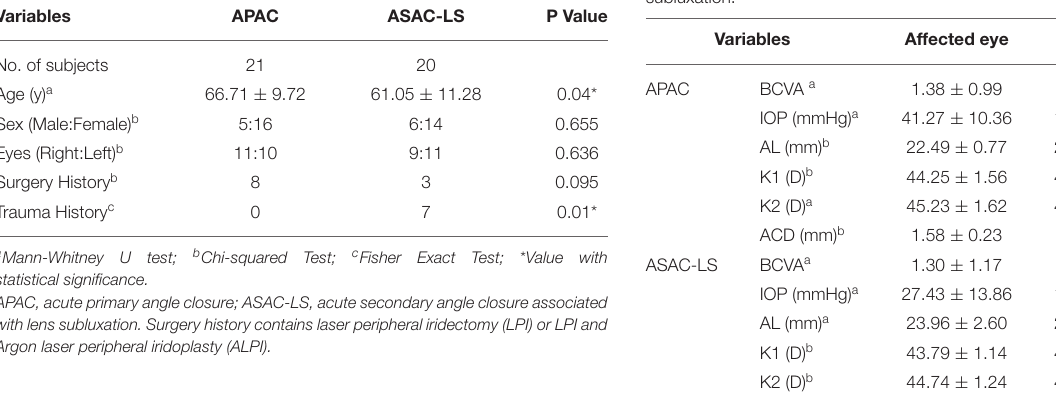
TABLE 3 | The intereye comparison of subjects in the acute primary angle closure cohort and acute secondary angle closure cohort, associated with lens subluxation. Variables Affected eye Fellow